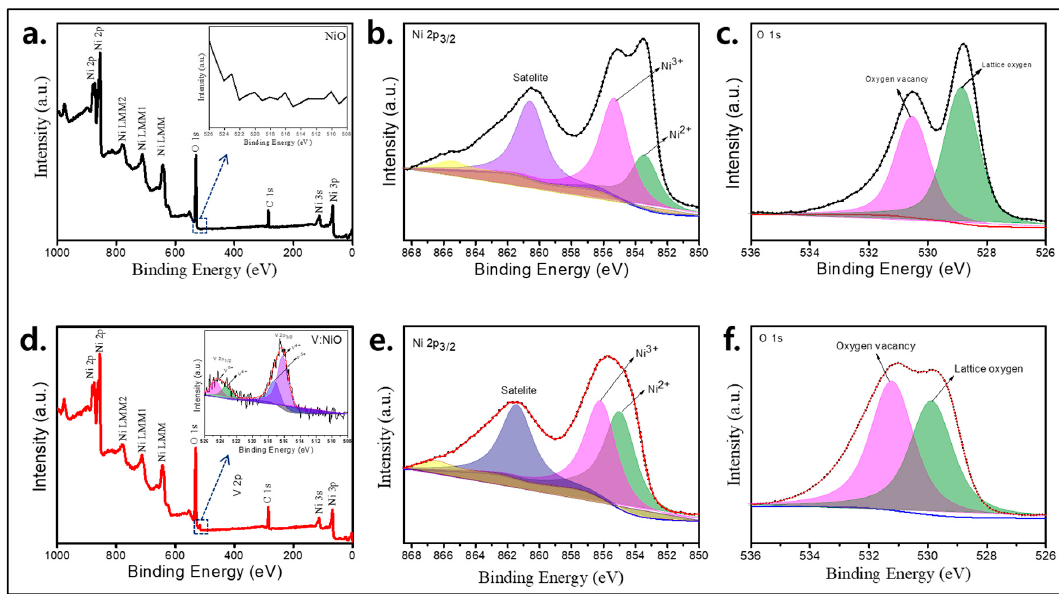
Figure 5. ( a – c ) XPS spectra of NiO: ( a ) survey spectra (inset: high-resolution spectra of V 2p), high-resolution ( b ) Ni 2p 3/2 and ( c ) O 1s; ( d – f ) XPS spectra of 3 at.%V:NiO: ( a ) survey spectra (inset: high-